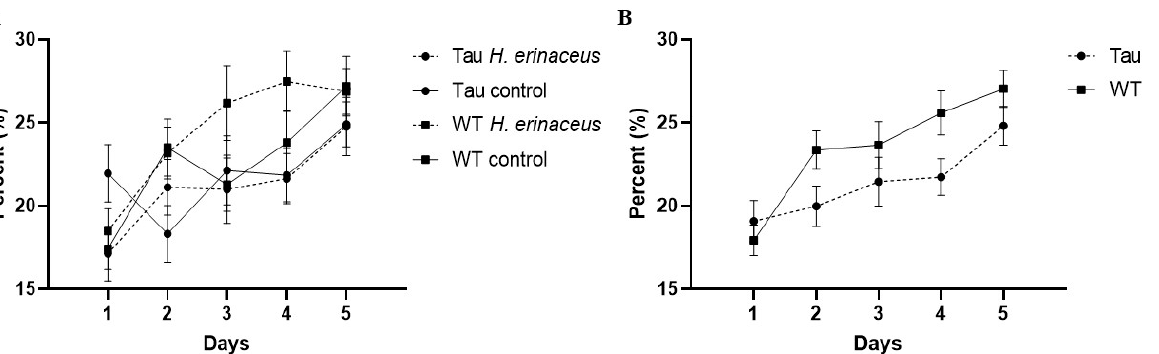
Figure 8. Percent time spent in the target quadrant of the MWM. ( A ) As the days progressed, mice spent more time in the target quadrant ( p < 0.001). ( B ) WT mice significantly spent more time in the target quadrant compared to tau mice ( p < 0.05). Error bars represent mean ±